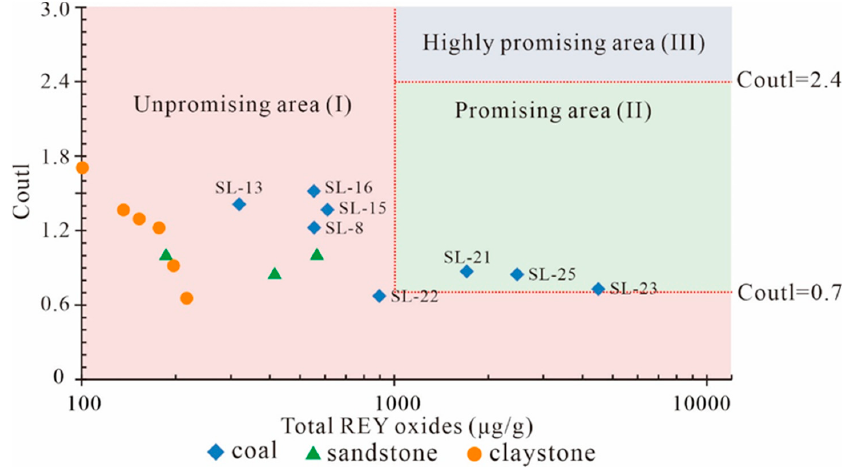
Figure 10. Evaluation of REY in coal ash and non-coal rocks from the Xian’an Coalfield.